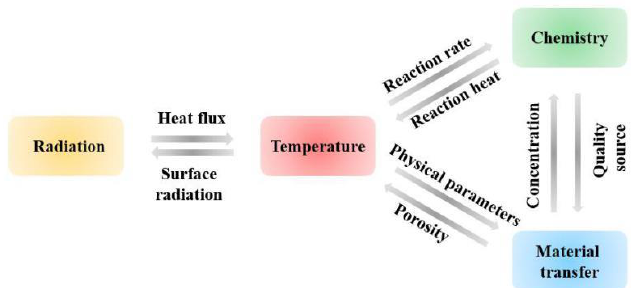
Figure 2. The coupling of Radiation–Heat–Matter–Chemistry (RHMC) in the bed model. The following assumptions were adopted in the multilayer ellipsoid pellet bed model.